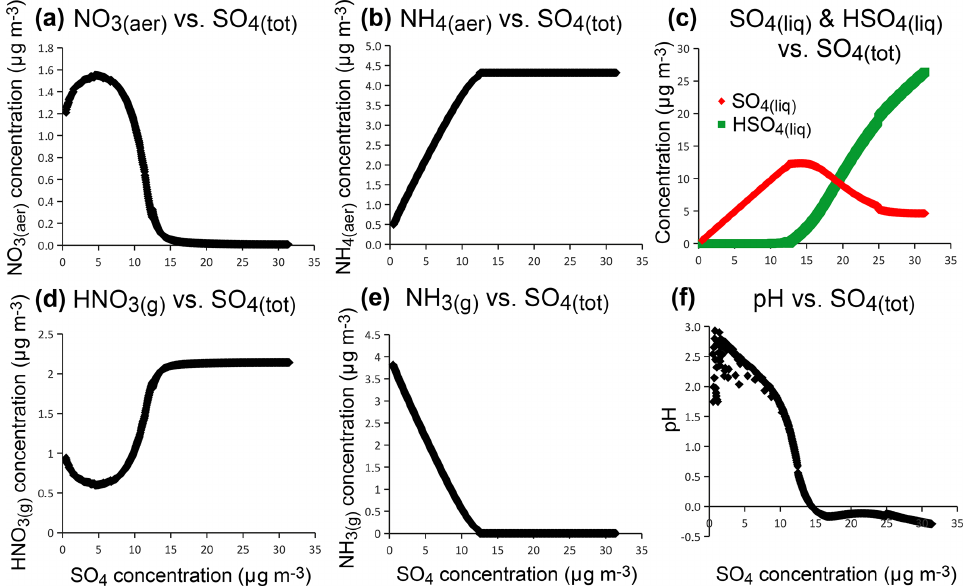
Figure 11. Sensitivity tests of aerosol composition (particulate NO 3 a , particulate NH 4 b , liquid SO 4 and HSO 4 c ), gas-phase composition (HNO 3 d , NH 3 e ) and pH (f) with increasing concentration with increasing concentration of total sulfate aerosols, using ISORROPIA II thermodynamic model for conditions met at SIRTA in September–October